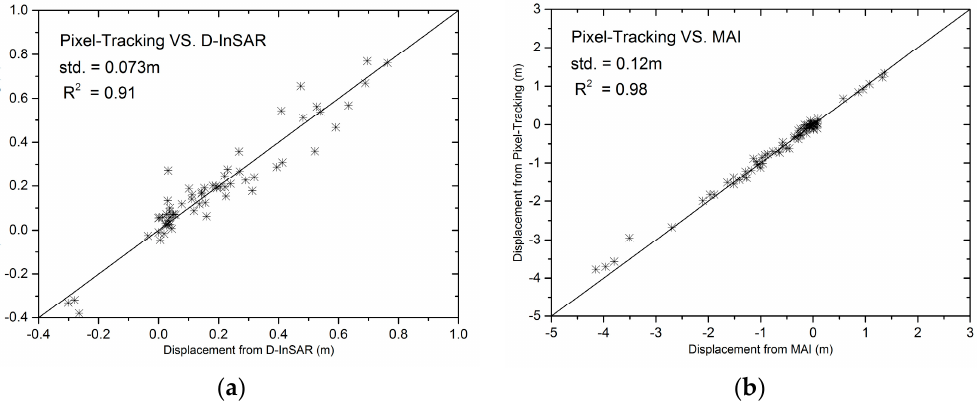
Figure 5. Correlation between D-InSAR/MT and PT in the overlapping region. ( a ) PT vs. D-InSAR; and ( b ) PT vs. MAI.